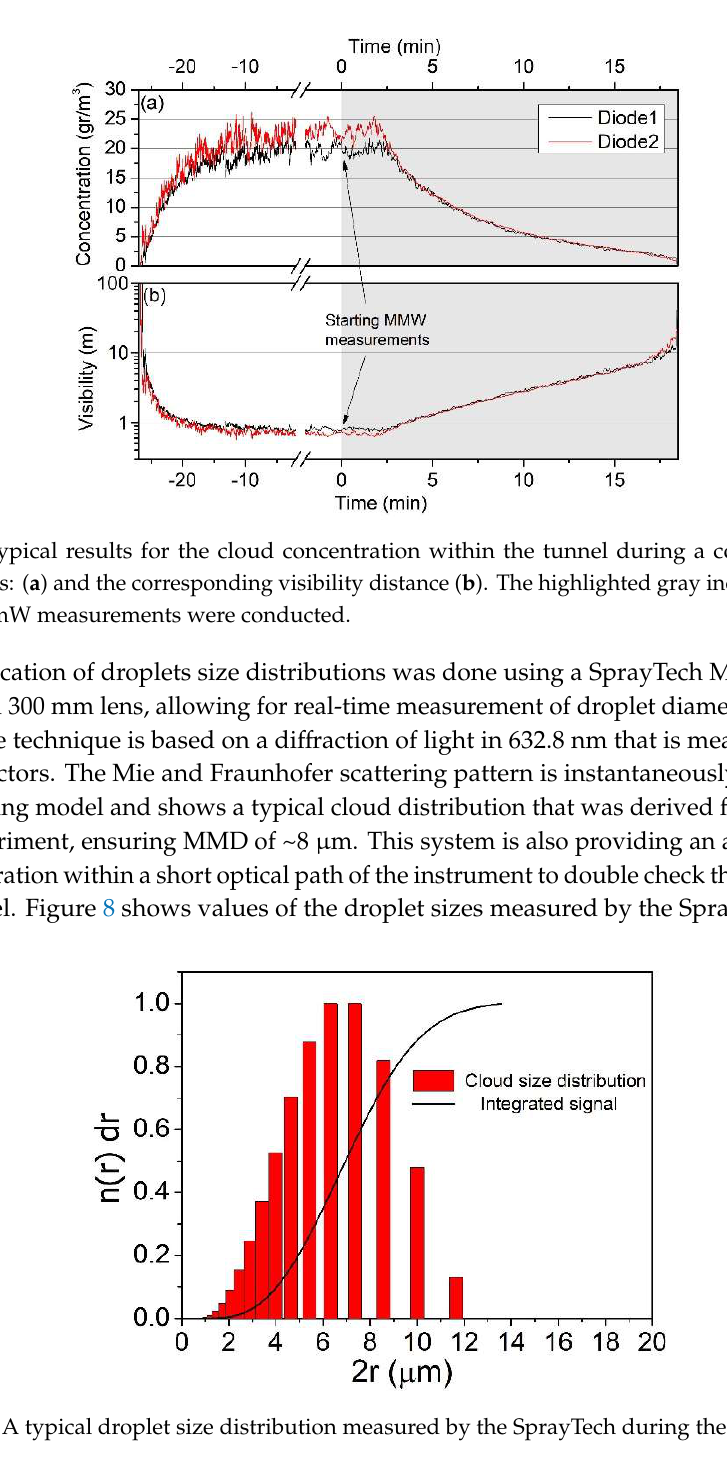
( b ) Figure 9. Experiment system: ( a ) the Network Analyzer connected to two horn antennas outside the chamber; ( b ) the horn antennas. 5. Visibility Measurement and Estimation of Water Droplet Concentration The visibility measurements were discussed elsewhere [17]. However, we will concentrate more on the experimental technique here. Two laser diode-based systems (ThorLabs CPS635) were simultaneously operated in different positions across the tunnel to measure the optical transmittance